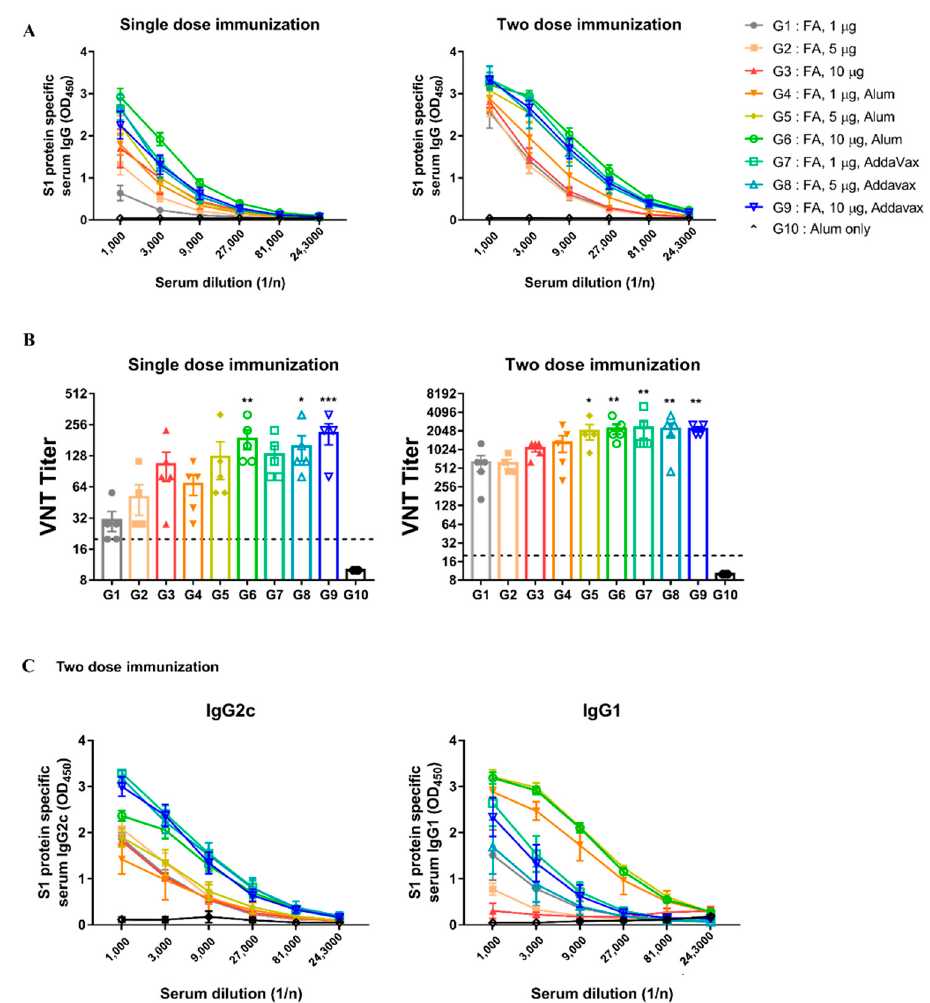
Figure 5. Immunization with inactivated-MERS-CoV with AddaVax has more effective protection against MERS-CoV. ( A ) MERS-CoV S1 protein-specific serum IgG levels were measured by ELISA. Serum was collected 2 weeks after immunization. ( B ) MERS-CoV specific neutralizing antibodies (nAbs) were determined by VNT. Serum was collected 2 weeks after immunization. ( C ) S1 protein- specific serum IgG2c/IgG1 levels were measured for two weeks later after two doses of immunization. Data are represented as the mean ± S.E.M. * p < 0.05, ** p < 0.01, *** p < 0.001 compared with G10 (Alum